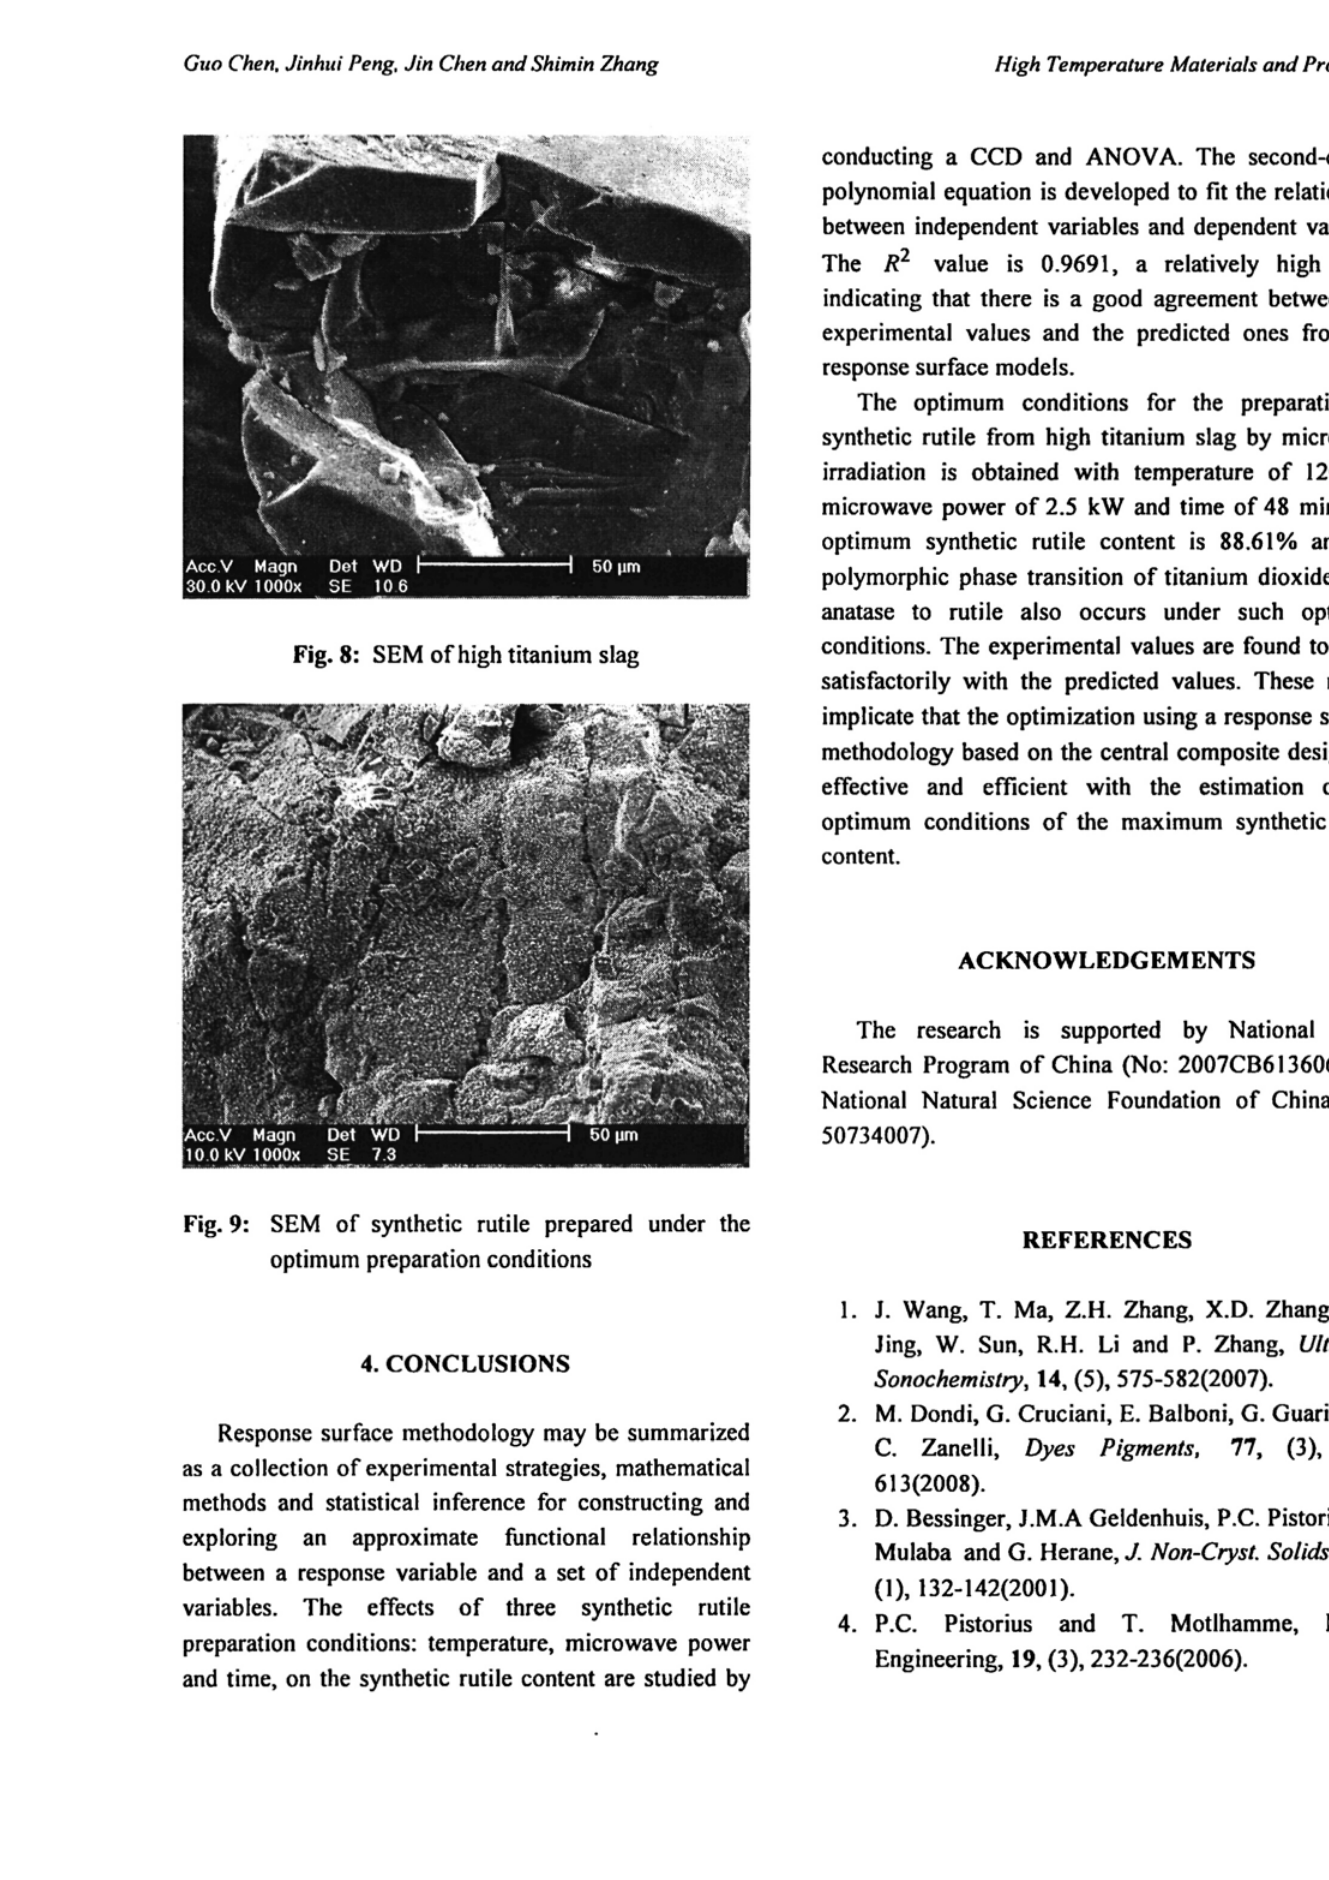
Fig. 9: SEM of synthetic rutile prepared under the optimum preparation